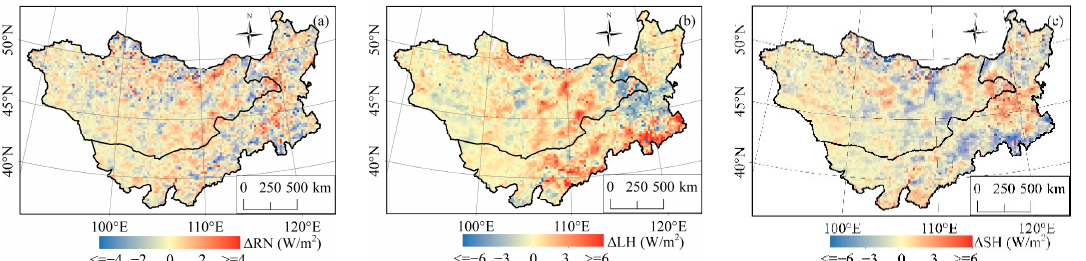
Figure 5. Model-simulated differences in the growing season net radiation ( a ), latent heat flux ( b ), and sensible heat flux ( c ) due to vegetation changes between scenarios of SL1990s and SL2010s.